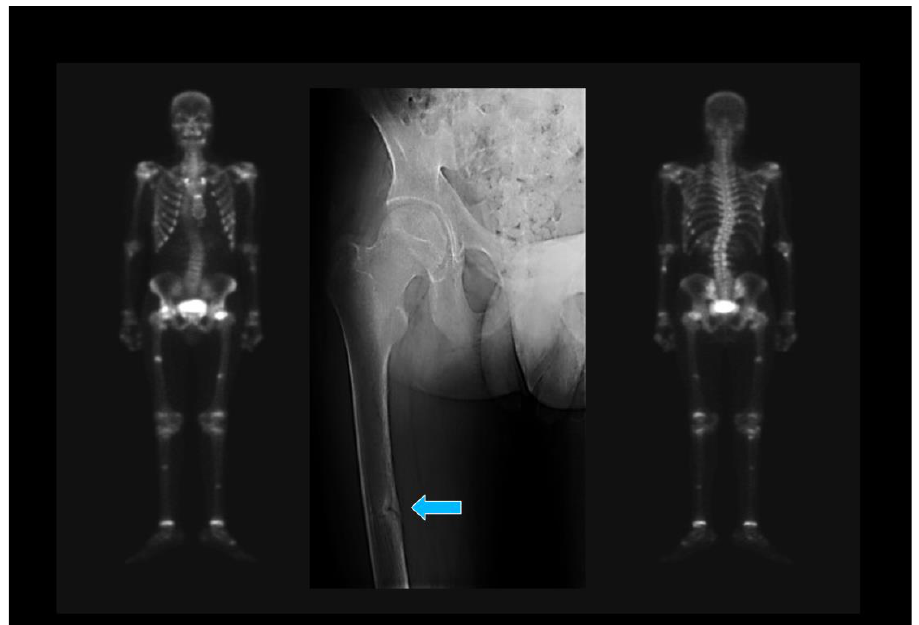
Figure 1. The typical scintigraphic pattern suggestive of metabolic bone disease can be seen on the left and right part of the image: increased uptake of the radiotracer in periarticular areas, skull, mandible, osteochondral junctions of the ribs, sternum, and focal increased uptake in the femur and tibia suggest Looser – Milkman zones. Conventional radiography (central part of the figure) shows a Looser – Milkman zone on the medial aspect of the middle third of the right femur (arrow). osteoporosis (Figure 2), radiographic osteopenia, and a pattern of trabecular bone thick- ening. Bone densitometry is of limited utility in OM, with low values being observed,